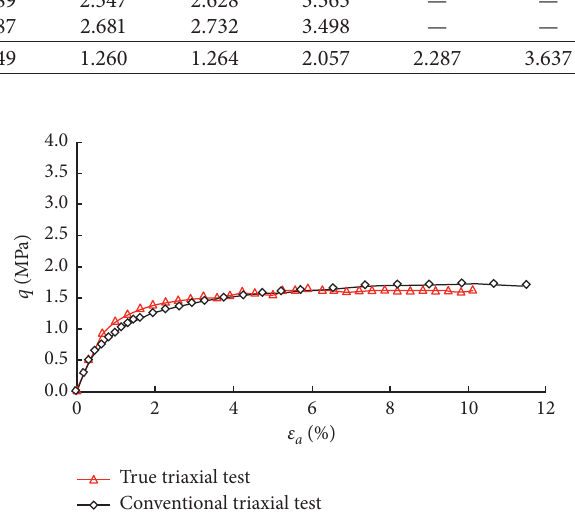
Figure 6: Comparative analyses of stress-strain curves at σ 3 � 0.4 MPa in the true triaxial test and in the conventional triaxial test.